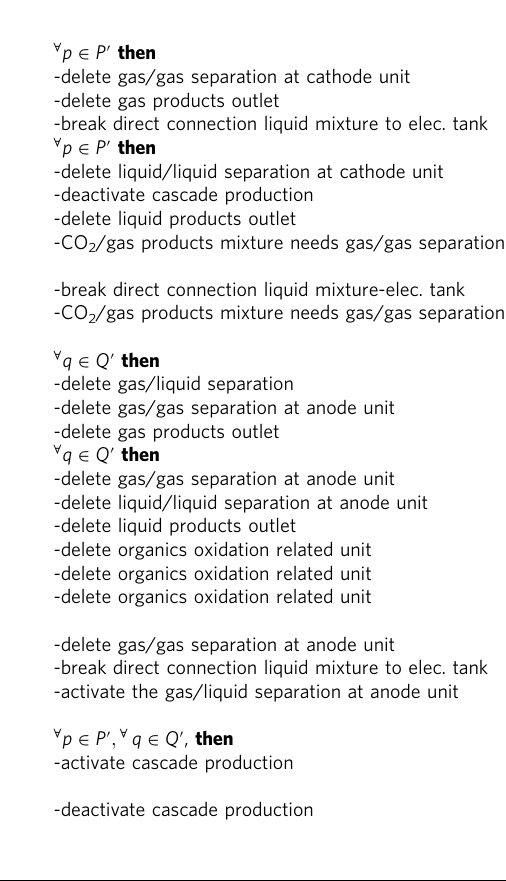
Table 2 The algorithm to reduce superstructure matrix G to sub-structure matrix Initialize ^ G ¼ G